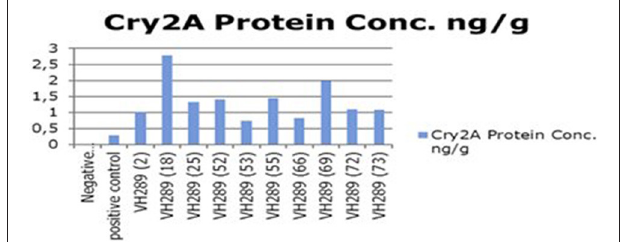
FIGURE 7 | Concentration of Cry2A protein of transgenic cotton plants at T